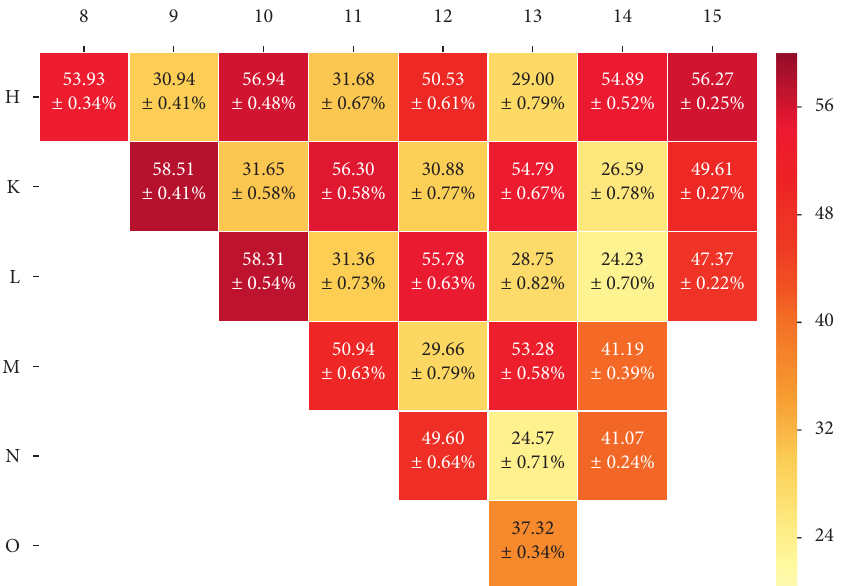
Figure 22: TMI-1 core burnup distribution with